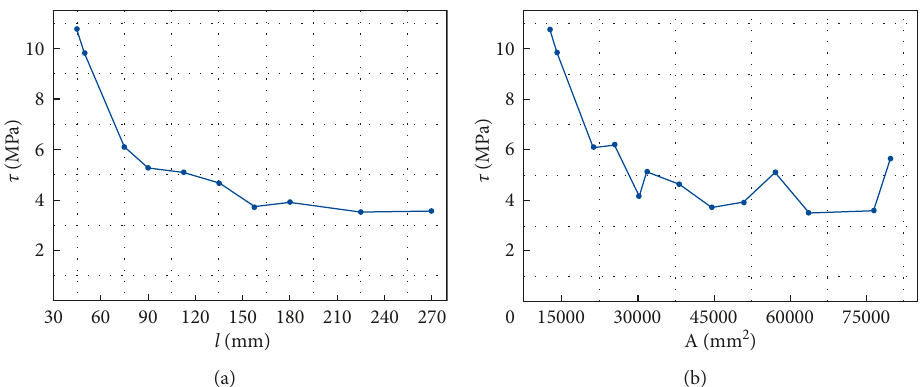
Figure 11: Influence of (a) bond length and (b) contact area on the bond stress of plastic bellow concrete